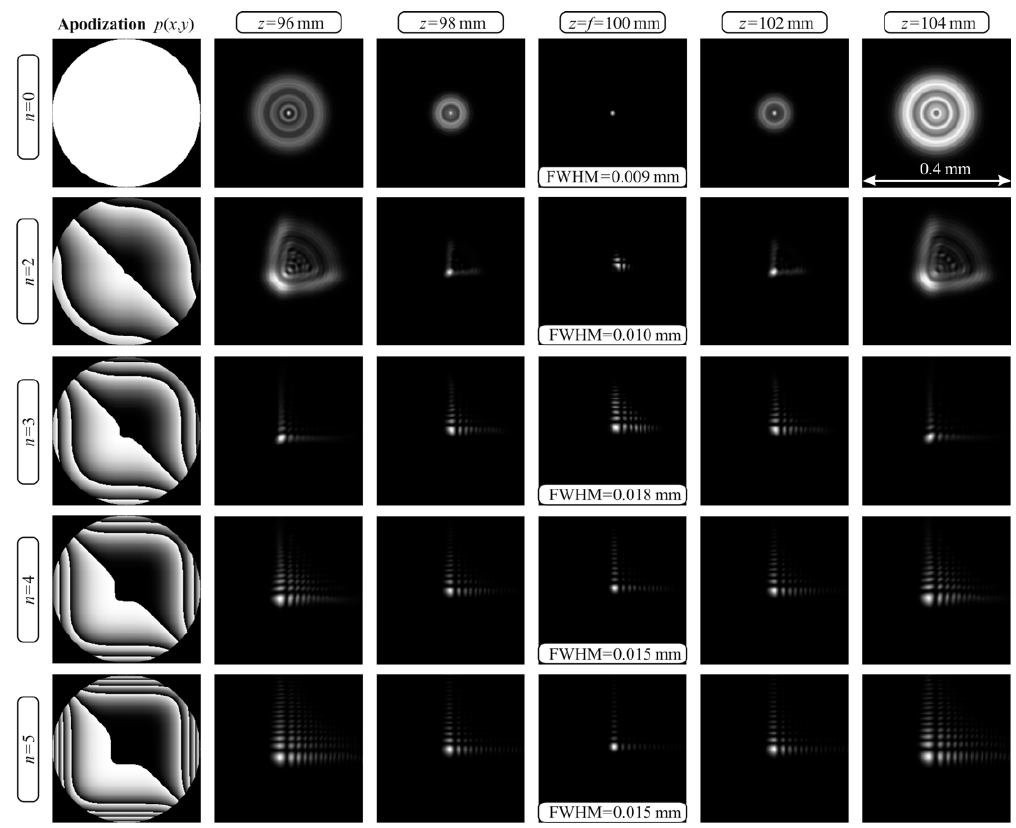
Figure 1. PSF with a CoC size limit of 0.02 mm at various distances (picture size 0.4 × 0.4 mm 2 ) for a lens without apodization (first row) and with asymmetric phase apodization of n = 2, α = 0.00025 (second row); n = 3, α = 0.00045 (third row); n = 4, α = 0.00054 (fourth row); and n = 5, α = 0.00081 (fifth row), with the wavelength of the illuminating beam λ = 550 nm.